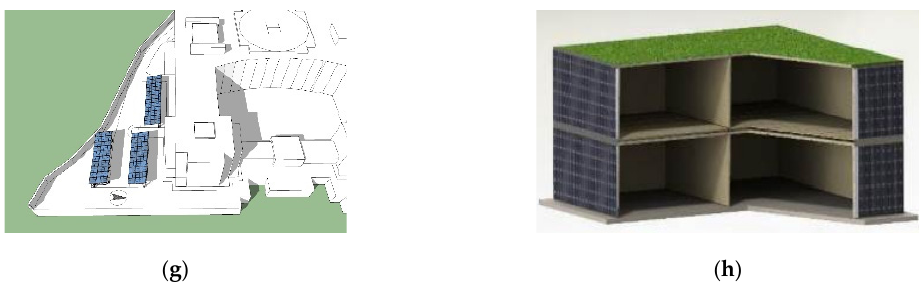
Figure 3. Indicative architectural designs of demonstration sites: ( a ) Bilbao, Oxtar Urban Gela (Spain); ( b ) Bilbao, Otxar residual building (Spain); ( c ) EYDAP building, Athens (Greece); ( d ) Cambium Fehring (Austria); ( e ) Arta service station (Greece); ( f ) Kalamata service station (Greece); ( g ) Athens administrative building (Greece); ( h ) Coimbra (Portugal).